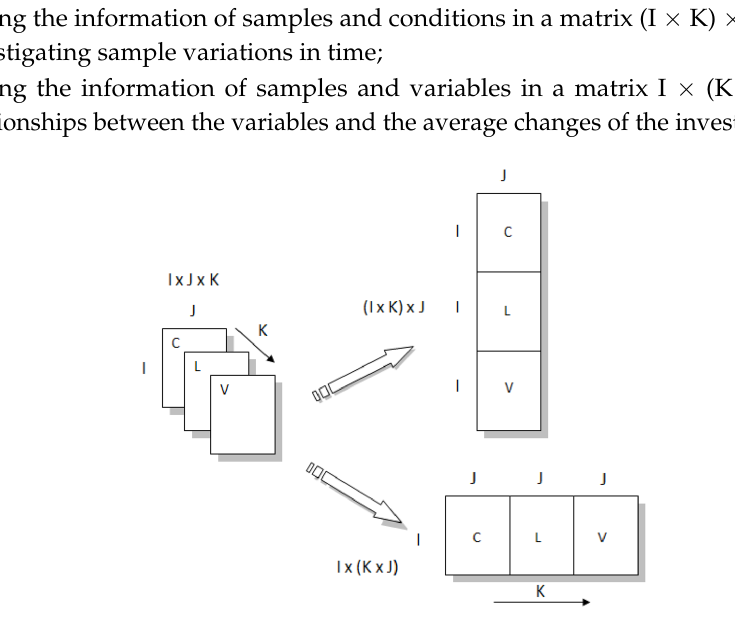
Figure 3. Schemes of rearranging: (I × K) × J and I × (K × J).